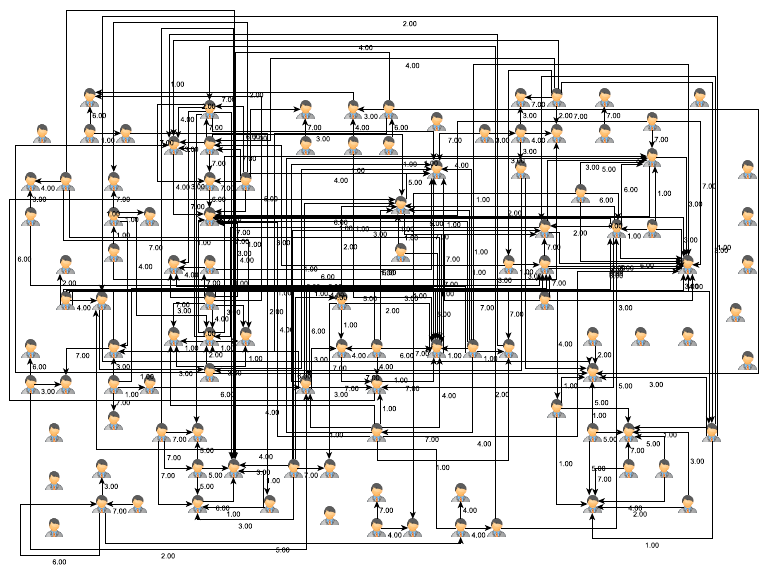
Figure 1. Network of